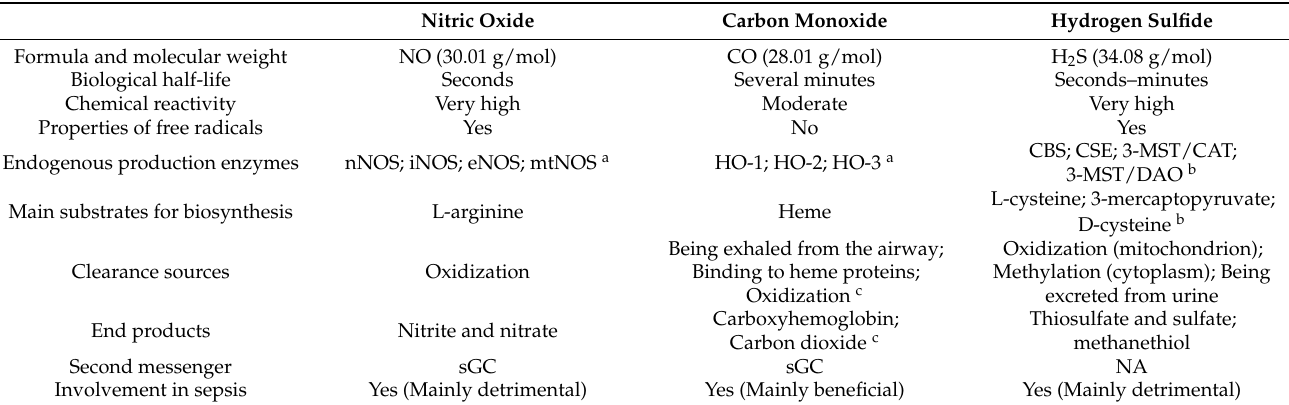
Table 1. Characteristics of currently recognized gaseous